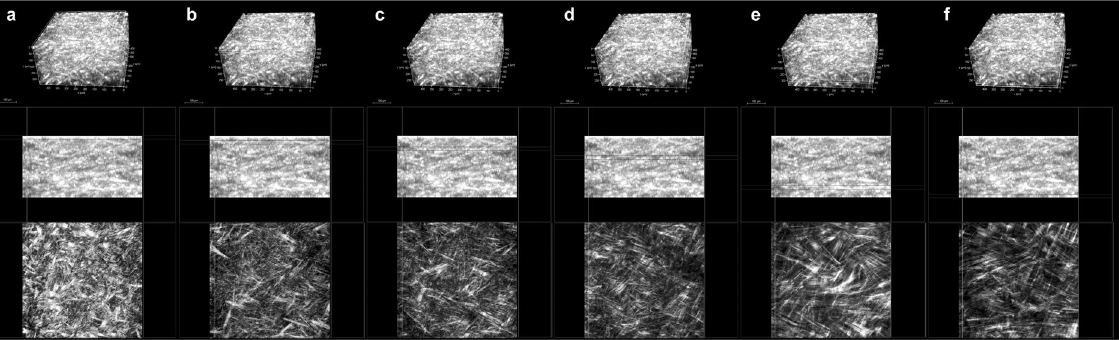
Figure 4. Organization of anterior stromal collagen fibers in the human cornea. (Upper row) 3D reconstruction of the anterior 250 µ m stroma of the human cornea (forward SHG signal) showing the depth-dependent organization and arrangement of collagen fibers (scale bar 100 µ m). Middle row) cross-section images of the corneal stroma; from the left to right, the boxes enclose regions of the stroma at varying depths, ranging from the most anterior stroma underlying the Bowman’s layer to 250 µ m depth. (Lower row) corresponding enface images of the stroma. In the most anterior stroma ( a ), the collagen fibers are arranging in tiny and short bundles densely intertwined at different planes; they arrange in thin and densely packed lamellae intersecting each other across 100- and 150- µ m depth ( b , c and d ); these lamellae become increasingly wider and thicker with increasing depth. From ≥ 200 µ m depth, the collagen lamellae shows a grid-like structure, crossing each other at almost vertical angles ( e and f ).